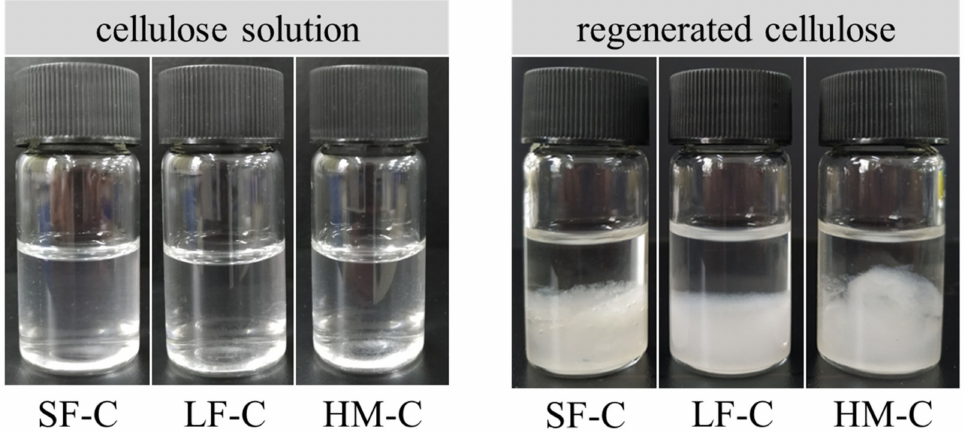
Figure 1. Photos of three kinds of cellulose aqueous solutions in 1.0-wt% glycerin / 9.0-wt% NaOH and regenerated cellulose by 3-M